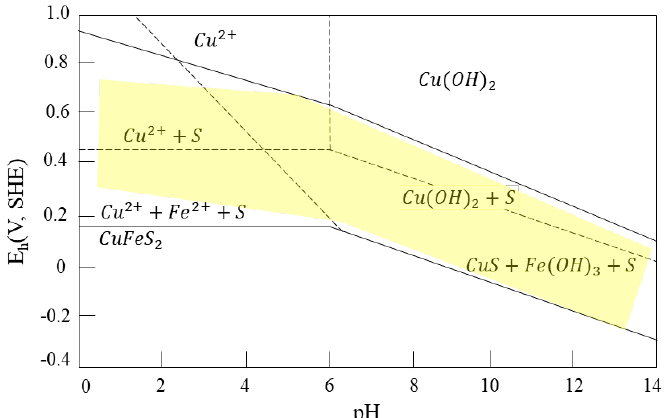
Figure 3. Eh-pH diagram for chalcopyrite with elemental sulfur as metastable phase (adapted from Hu et al. [8]).